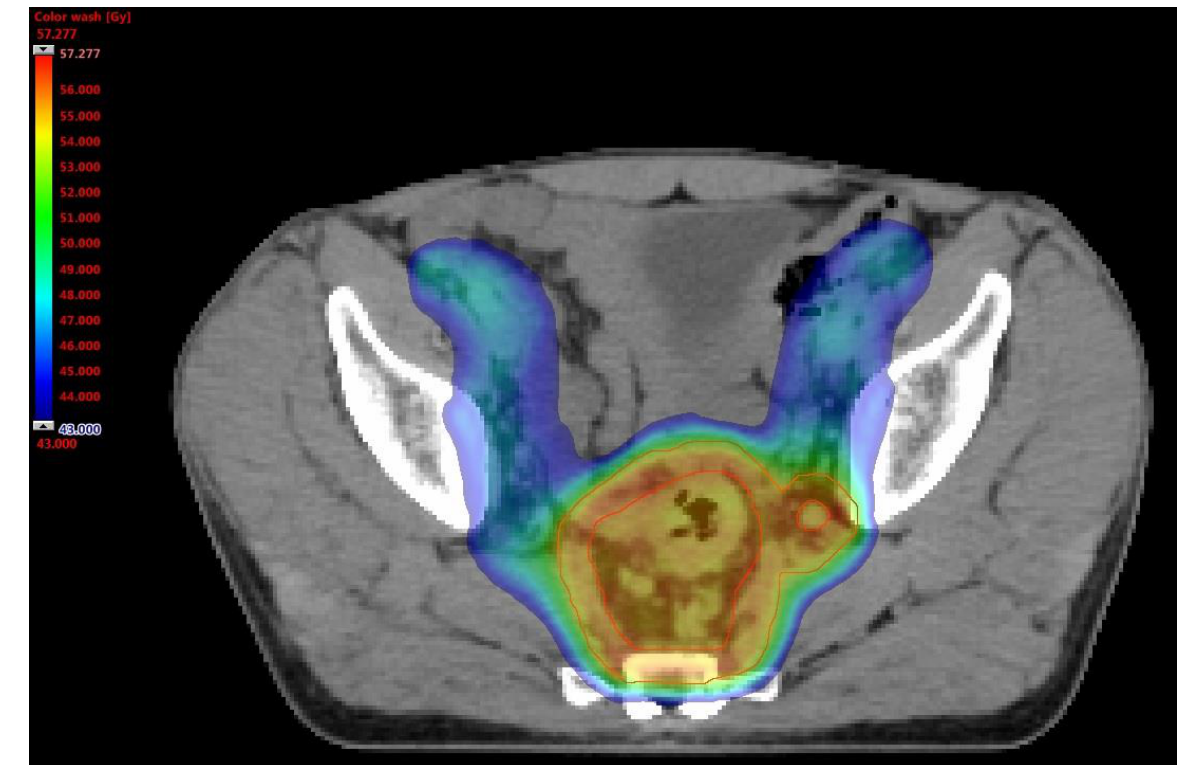
Figure 2. Flowchart of the clinical workflow. LARC: Locally Advanced Rectal Cancer; LPLN: Lateral Pelvic Lymph Nodes; RT boost yes/no: Radiotherapy boost yes/no; LC CRT: Long Course chemora- diotherapy; SC CRT: Short Course chemoradiotherapy.